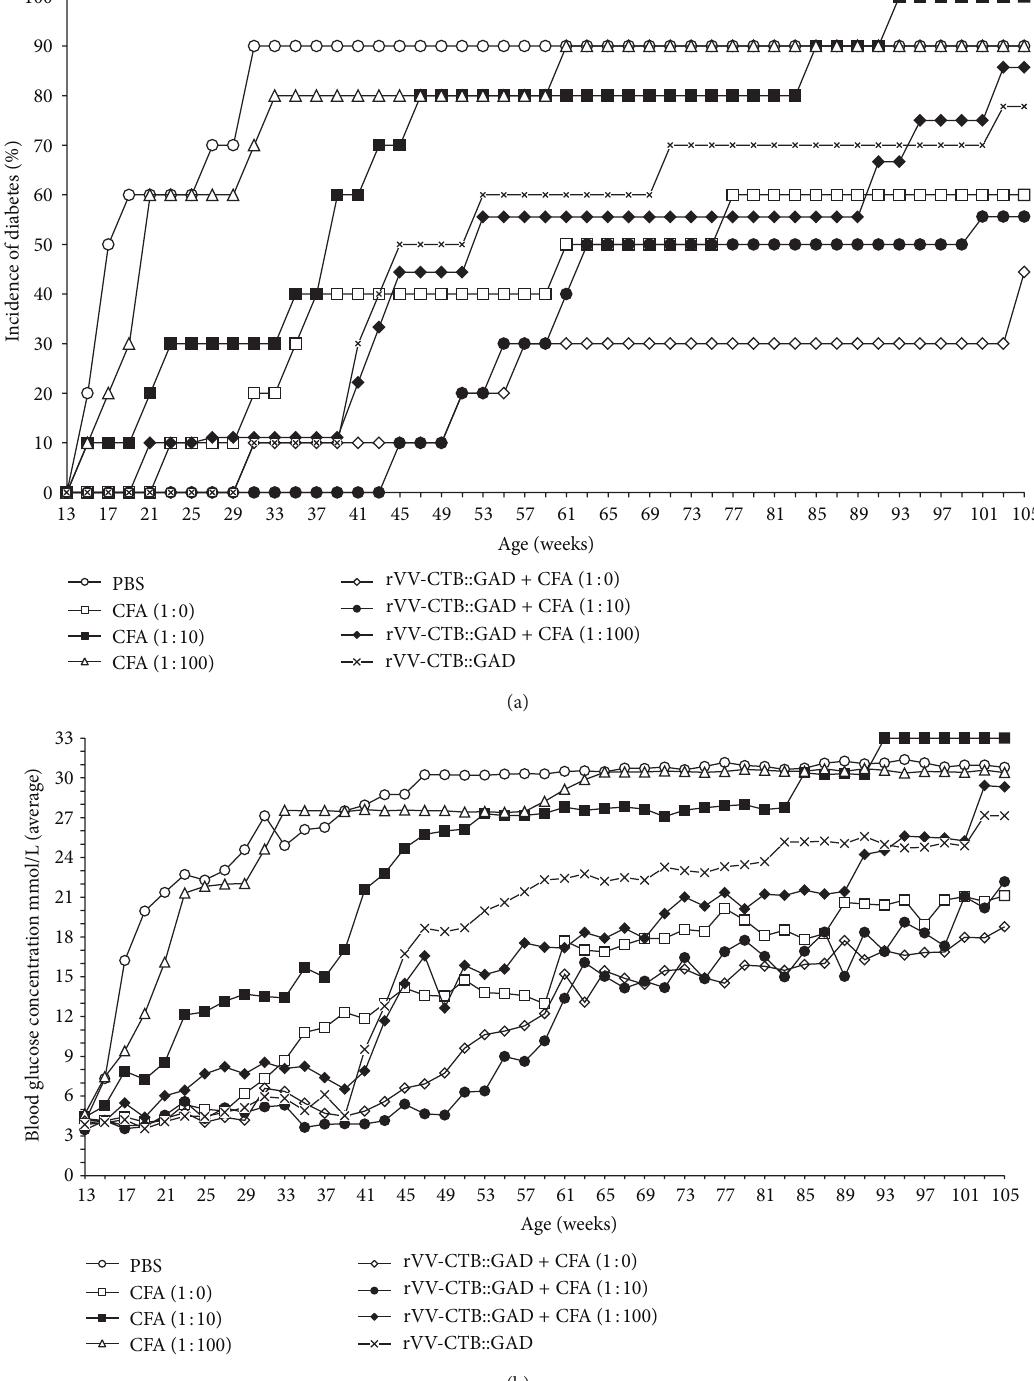
Figure 1: Incidence of diabetes in nonobese diabetic (NOD) mice. (a) Comparison of immunological suppression protocols on diabetes onset in NOD mice as determined by increased incidence of hyperglycemia. Treatment with rVV-CTB::GAD alone and coinoculation with CFA demonstrated statistically significant differences ( 𝑃 < 0.01 –0.001) compared to the phosphate-buffered saline (PBS) (mock-infected) control group. Differences between CFA (1: 10), CFA (1:100), and PBS treatment groups are statistically insignificant (Mann-Whitney U test). (b) Blood glucose levels in all experimental animal groups were monitored biweekly. Each data point represents the average blood glucose determination for all mice in that group until 105weeks of age. Starting from 107 weeks of age several mice have died from unknown and unrelated to diabetes reasons; the figure does not show data points between 107 and 119 weeks. By the end of the experiment, highest blood glucose levels were detected in naive mice inoculated with PBS, CFA (1:10), and CFA (1:100), reaching average levels of 31, 33, and 30 mmol/L, respectively. Lowest levels of blood glucose maintenance were found in NOD mice inoculated with rVV-CTB::GAD + CFA (1:0) (18.8mmol/L), CFA (1:0) (21.1mmol/L), and rVV-CTB::GAD + CFA (1:10) (22.2 mmol/L). Differences in the average blood glucose levels in all groups were statistically significant ( 𝑃 < 0.05 –0.001) compared to naive controls, except group of mice inoculated with CFA (1:100) (Mann-Whitney U